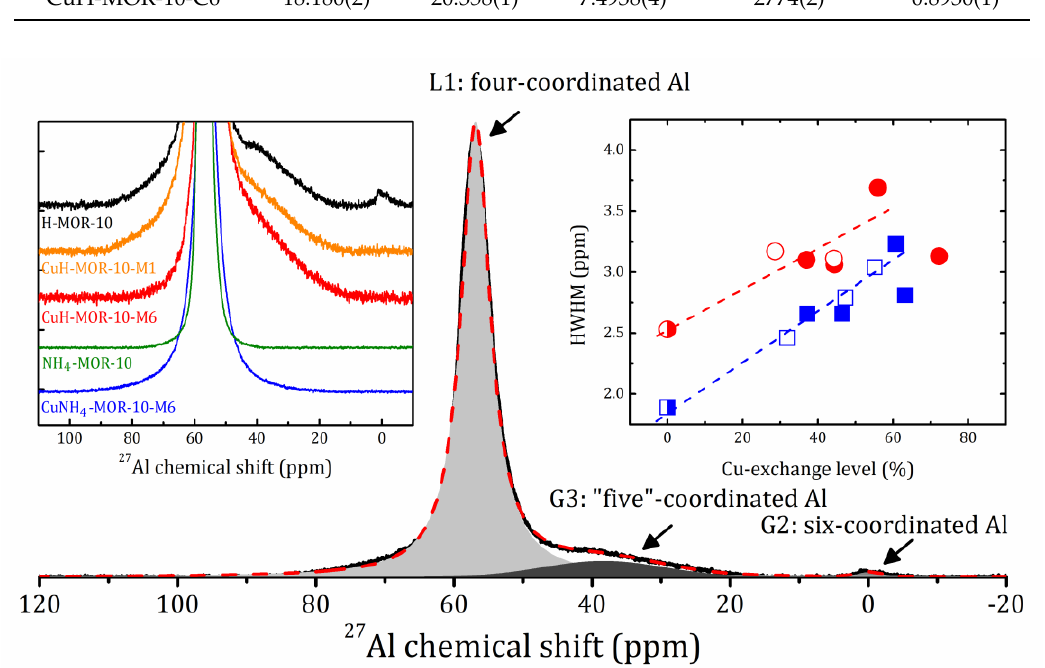
Figure 2. 27 Al MAS NMR spectrum and its decomposition on one Lorentzian (L1) and two Gaussian (G2 and G3) lines for H-MOR-10 at rotation frequency 8 kHz. Left insert: 27 Al MAS NMR spectra of the selected samples. Right insert: the half width at half maximum (HWHM) of the L1 line versus the Cu-exchange level for the CuNH 4 -MOR-10- XY (squares) and CuH-MOR-10- XY (circles) samples. Open and closed symbols correspond to the conventional and MW-assisted treatment, respectively; semi-closed symbols represent the starting materials. Dashed lines correspond to the linear fitting of all the data for the samples with Cu-exchange level below 60%.